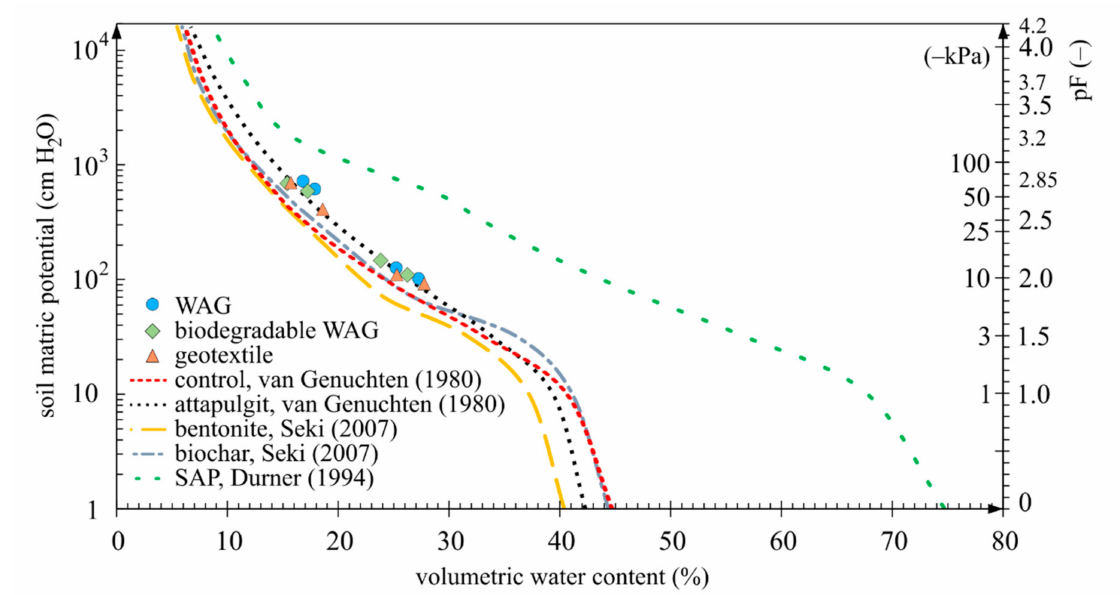
Figure 7. Summary chart of water retention characteristics of soil containing the soil amendments (drying curves) in loamy sand. Mean moisture values of pot samples amended with solid-state amendments such as WAG, bioWAG and nonwoven geotextile are added to the chart. The curves are plotted on the basis of data from the pressure plate apparatus and hydraulic models ( n = 120).